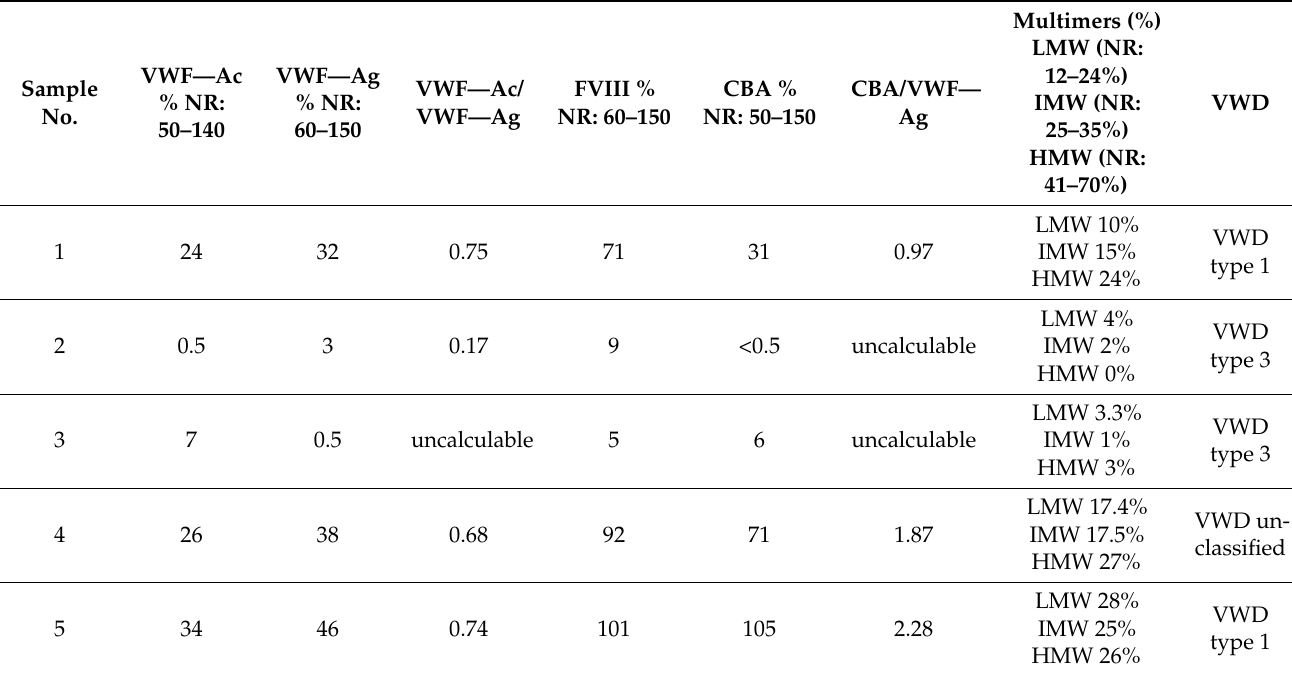
Table 2. The laboratory results and type VWD of all